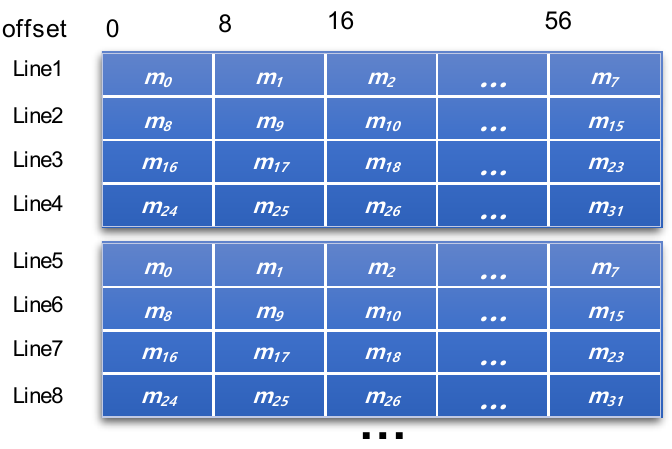
Figure 1. Memory layout of the multiplier table in